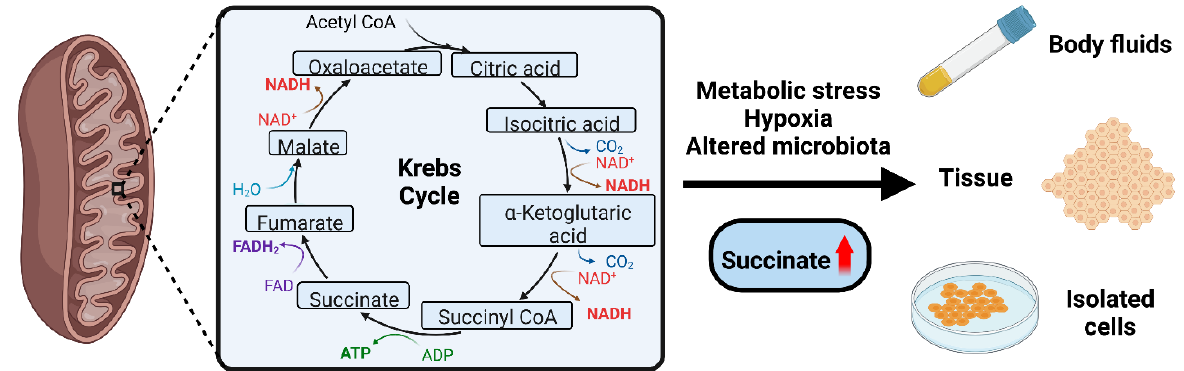
Figure 2. Succinate accumulation occurs in metabolic stress conditions. Succinate is an intermediate metabolite in the Krebs cycle. In conditions of metabolic stress/hypoxia/microbiome alterations, succinate concentrations rise beyond physiological values. Succinate can be measured in biological fluids or tissues, or in isolated cells exposed to stress. Red arrow denotes increased succinate levels.